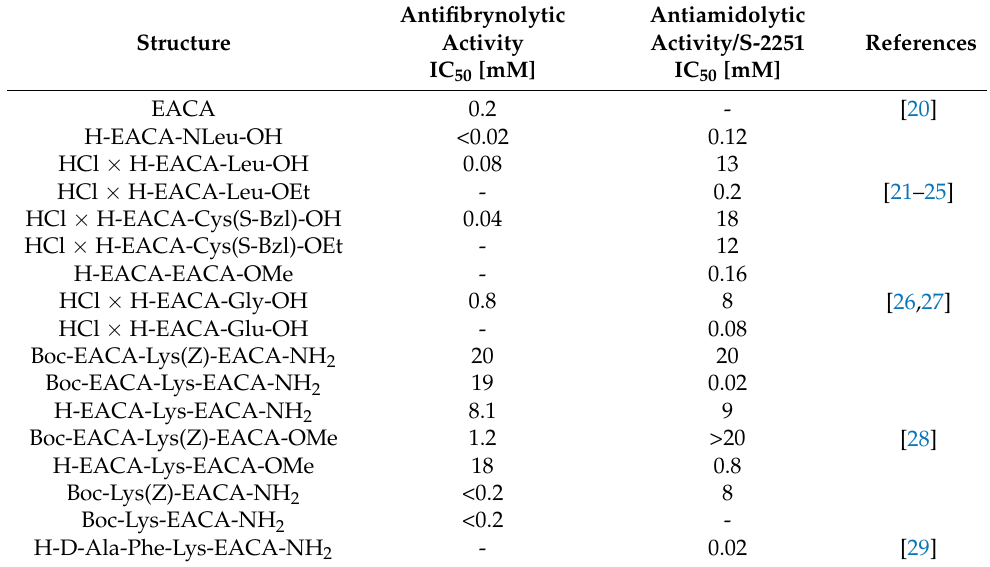
Table 1. Biological activity of peptides analogs of